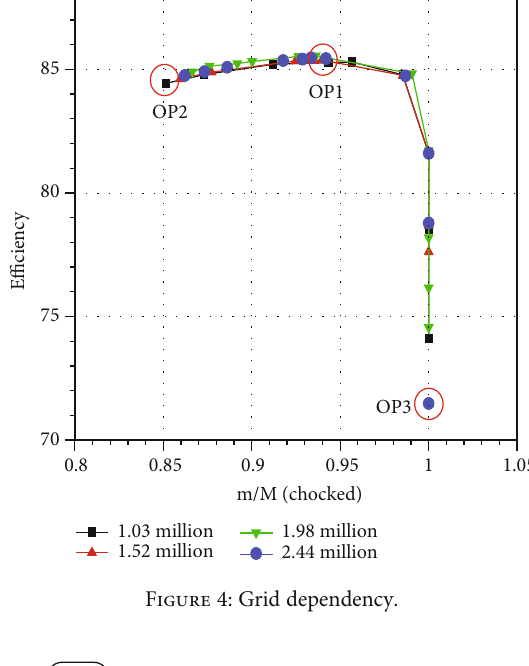
Figure 4: Grid dependency.